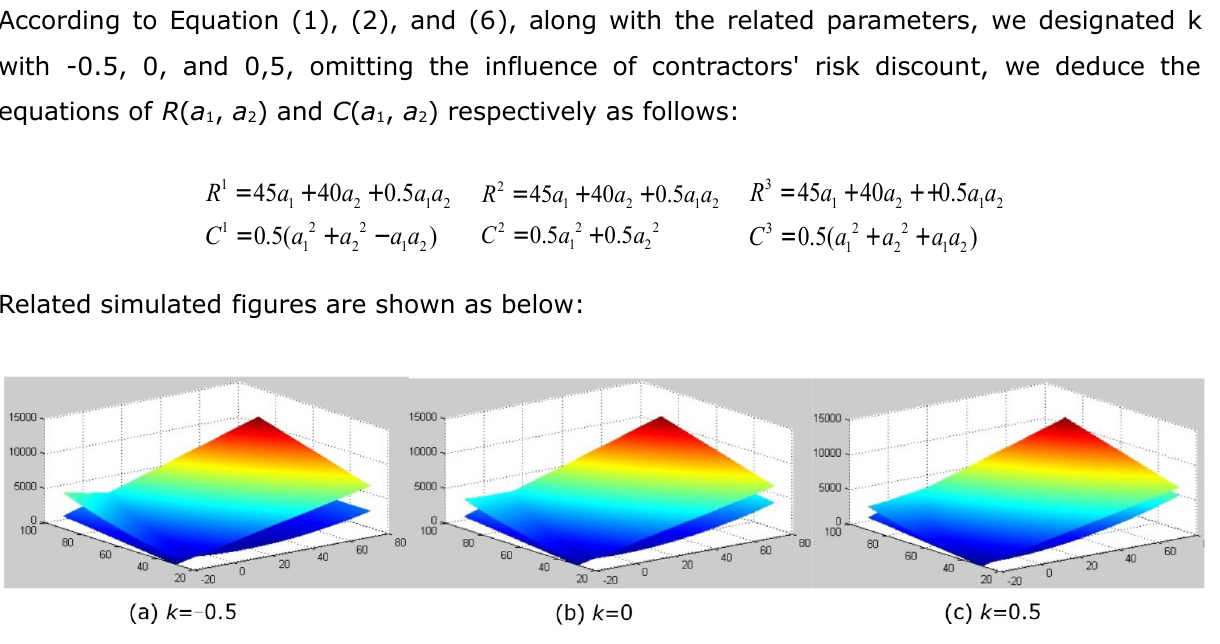
Figure 4. Relationship between project values added and knowledge investment and knowledge innovation synergism with different k